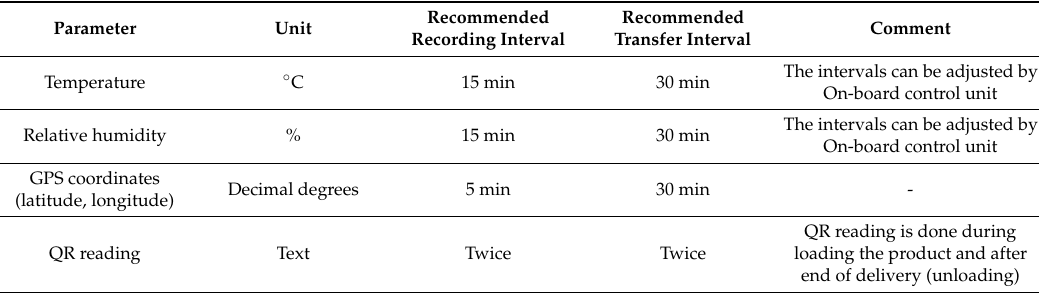
Table 4. Smart box data recording and transferring